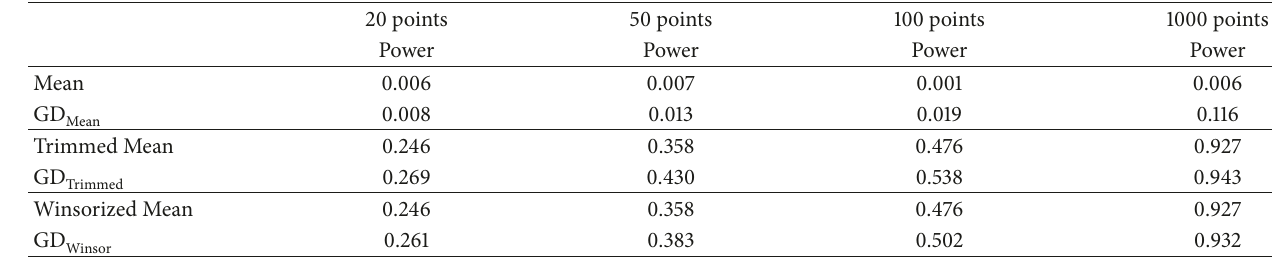
Table 61: G-h distributions with 30% noise